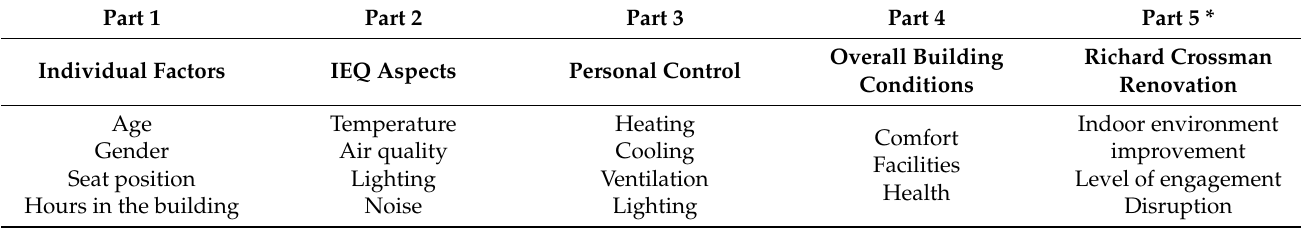
Table 6. User satisfaction survey